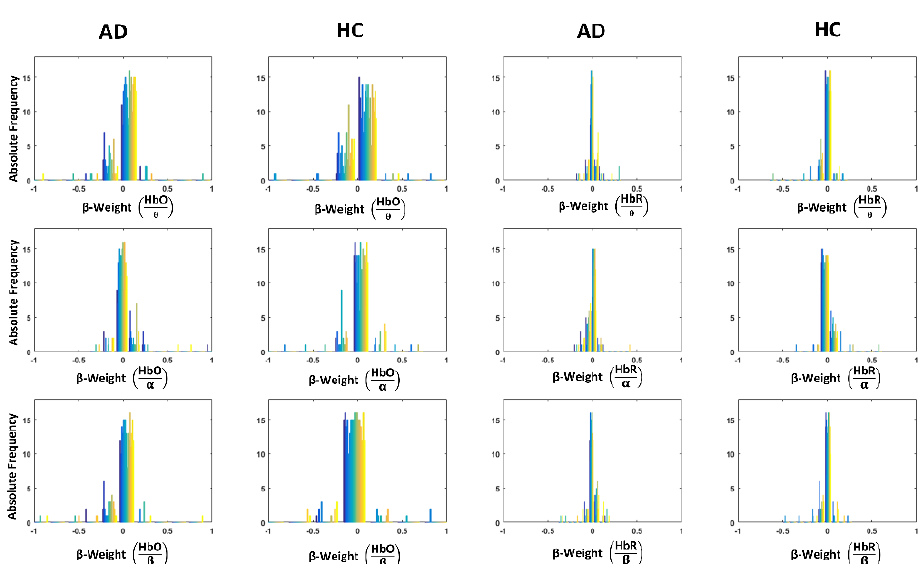
Figure 4. Distributions of the GLM standardized β-weights for the fNIRS long separation channels depicting the linkage of the 1st PCs of the three EEG power envelopes in theta (θ), alpha (α) and beta (β) bands with HbO and HbR changes in AD and HC. The different colors represent different subjects.